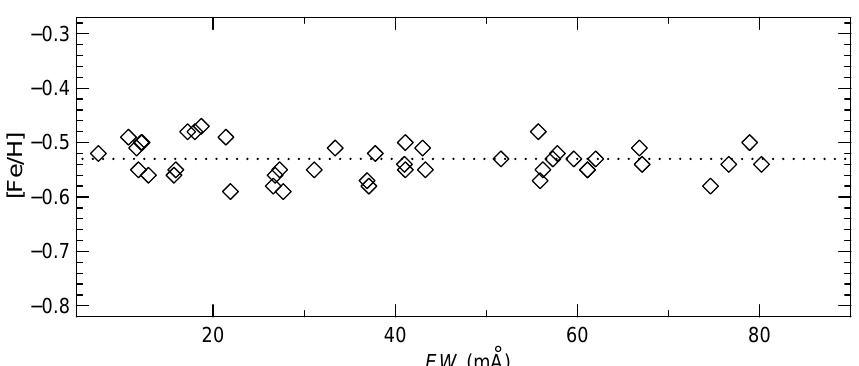
Fig. 2. [The Fe i /H] abundance values versus the equivalent widths for (cid:21) And. The mean abundance ([Fe i /H]= (cid:0) 0 : 53 dex) is shown by a dotted